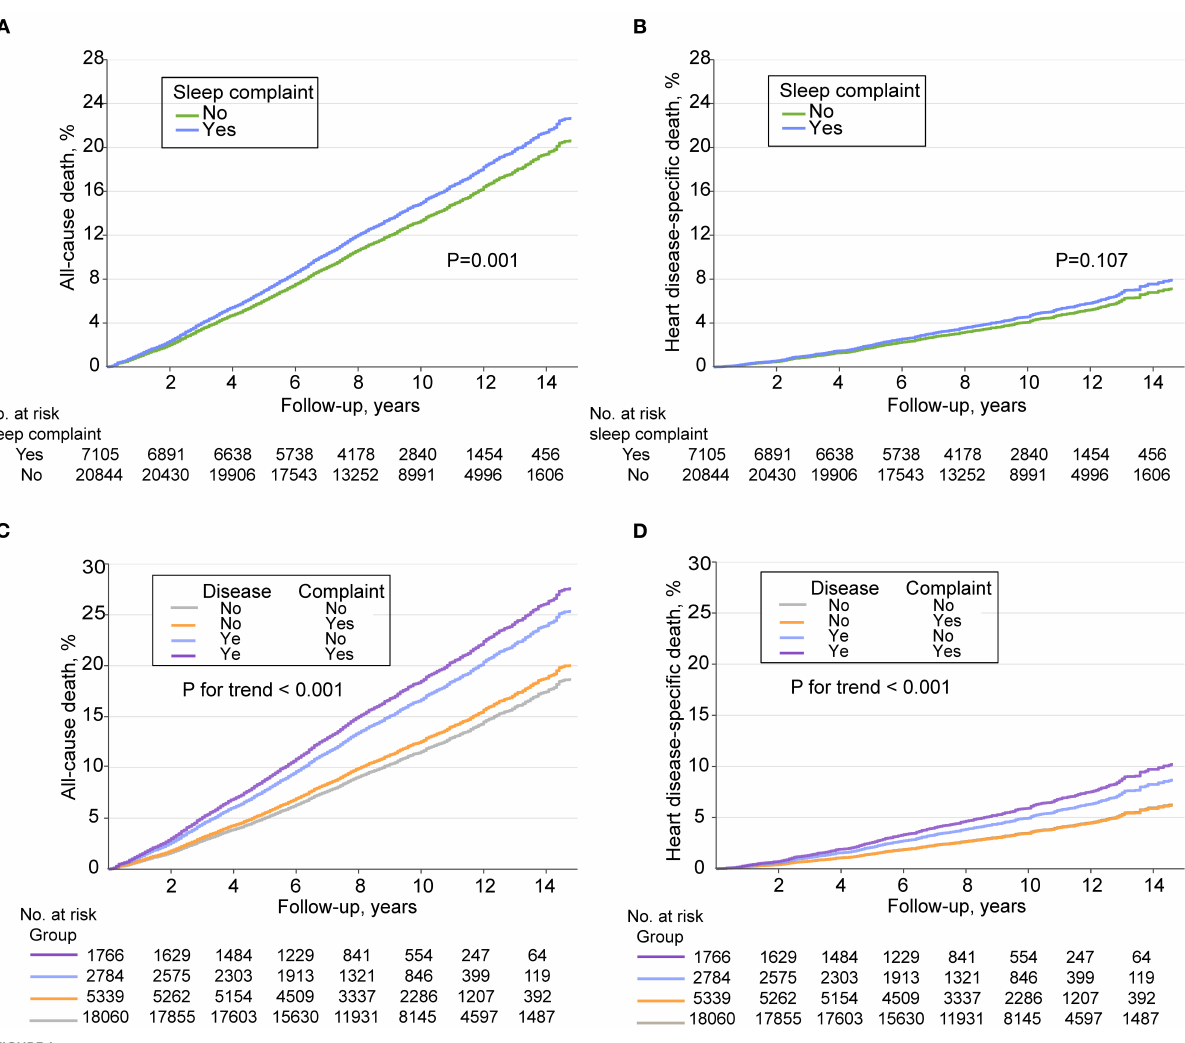
FIGURE1 Adjusted cumulative incidence curves of all-cause and heart disease mortality among adults in the National Health and Nutrition Examination Survey 2005 through 2014. (A) Adjusted cumulative incidence curves of all-cause mortality stratified by sleep complaints. (B) Adjusted cumulative incidence curves of heart disease mortality stratified by sleep complaints. (C) Adjusted cumulative incidence curves of all-cause mortality stratified by cross groups of sleep complaints and disease (cardiovascular disease or cancer). (D) Adjusted cumulative incidence curves of heart disease mortality stratified by cross groups of sleep complaints and disease (cardiovascular disease or